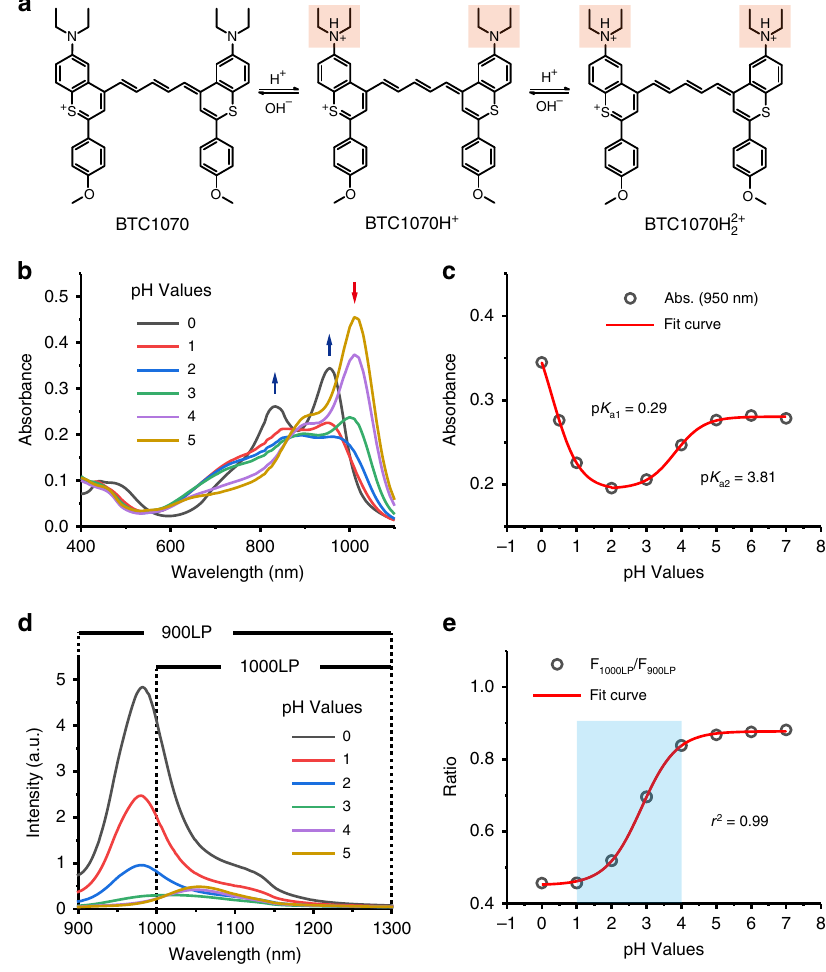
Fig. 5 Protonation of BTC1070 and the corresponding spectra changes. a Protonation mechanism of BTC1070 derived from the 1 H-NMR titration in Supplementary Figure 22, showing stepwise protonation on nitrogen atoms. b Absorption spectra of 10 μ M BTC1070 loaded into phospholipid nanomicelle in PBS at various pH values. Detailed data in a wider pH range of 0 – 9 are shown in Supplementary Figure 19. c Plot of absorbance at 950 nm versus pH values in the range of 0 – 7. The p K a values are calculated to be 0.29 and 3.81, respectively, based on Boltzmann curve fi tting in origin software. d The corresponding fl uorescence spectra excited at 808 nm at various pH values. e Plot of fl uorescence ratio changes as a function of pH values. Ratio = F 1000LP /F 900LP , F 1000LP and F 900LP denote the integrated intensity at wavelength of 1000 – 1300 nm and 900 – 1300 nm,